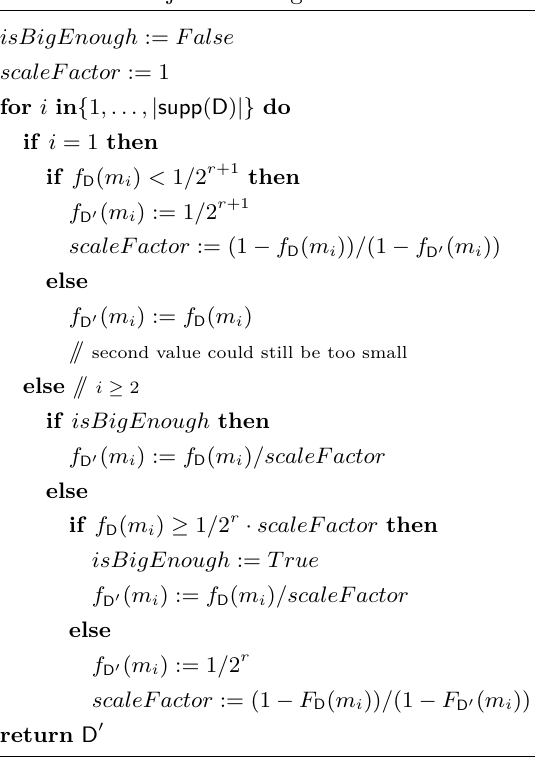
, will have 2 l |M|